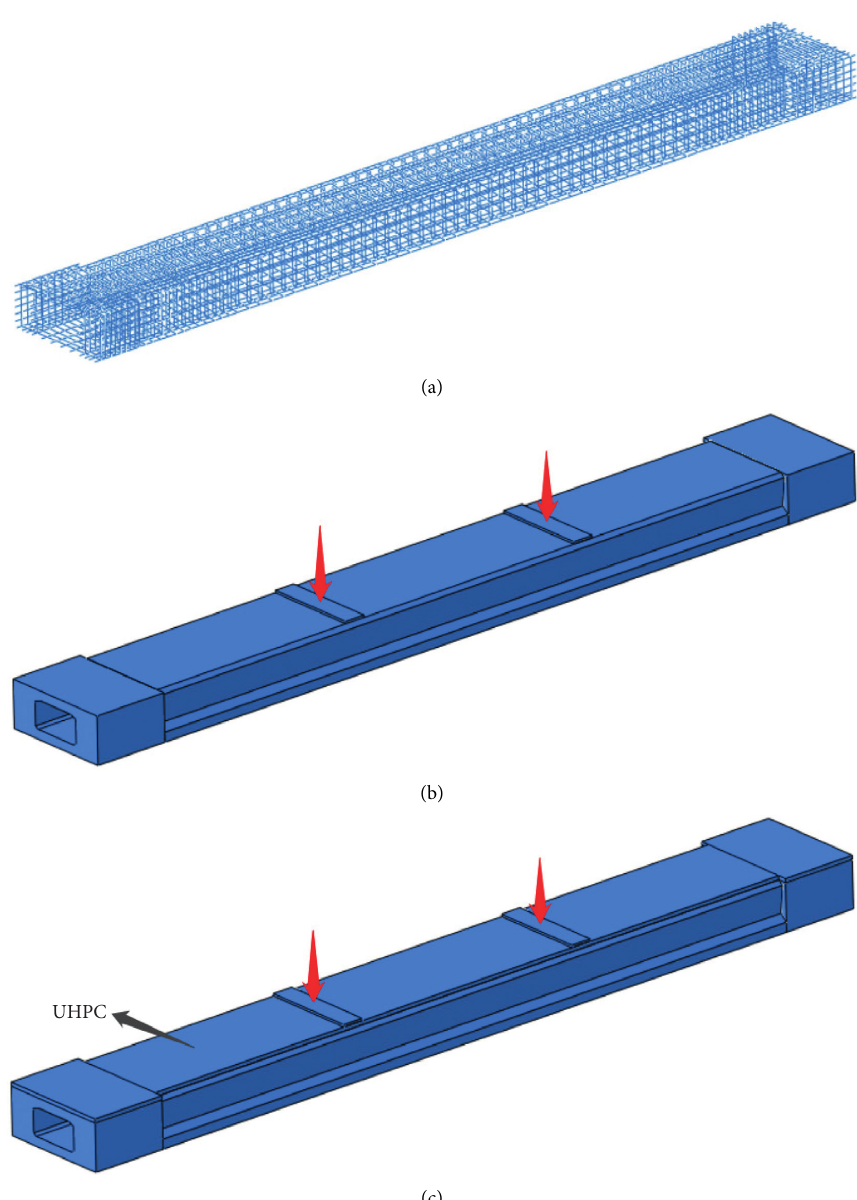
Figure 18: The finite element model of hollow slab strengthened by UHPC. (a) The reinforcement mesh. (b) Hollow slabs. (c) The hollow slabs strengthened by UHPC.